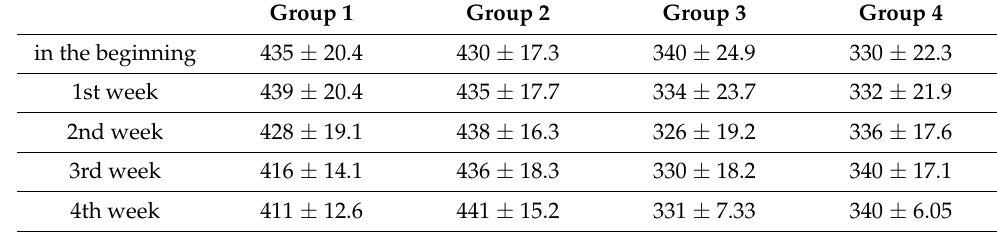
Table 2. The mean body weight values of rats in the different groups during the study ± standard deviation (SD). Group 1 Group 2 Group 3 Group 4